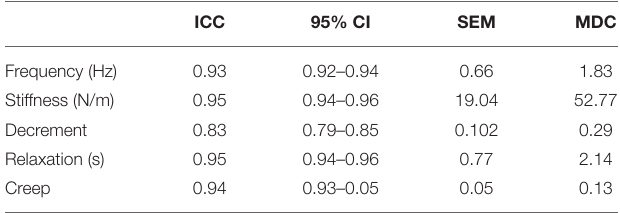
TABLE 1 | Intraclass correlation coefficient of MyotonPro measurements on the